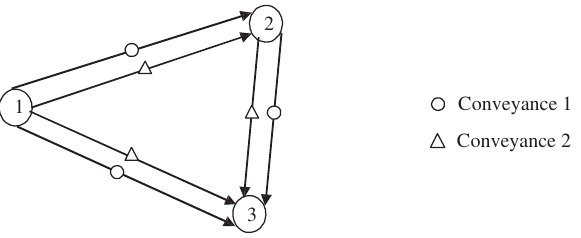
Figure 2: Network Representing Intuitionistic Fully Fuzzy CSMCF Problem.